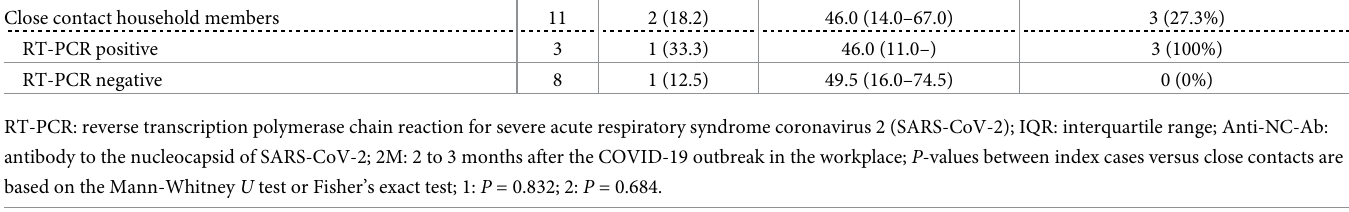
Table 1. Gender and age distribution of the participants and their SARS-CoV-2 PCR and anti-NC-Ab results at 2M. N Sex Male (%) Age Median, IQR (years) Anti-NC-Ab positive at 2M, n (%) Index cases (RT-PCR positive) Closed contact colleagues (RT-PCR negative or not tested)